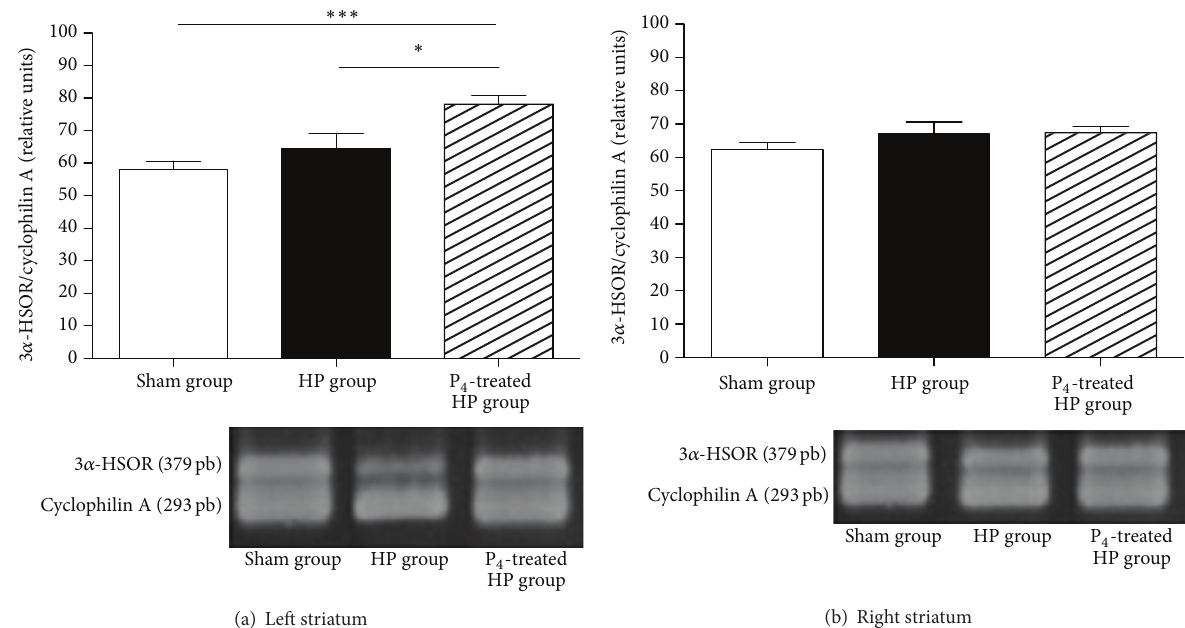
Figure 4: Gene expression of 3 𝛼 -HSOR in left (a) and right striatum (b). Results are expressed as mean ± SEM of relative units cDNA of sham, HP, and P 4 -treated HP groups; ∗ 𝑃 < 0.05 and ∗∗∗ 𝑃 < 0.001 (one-way ANOVA). Ethidium bromide fluorescence photograph of the gel electrophoresis of the amplification products, of sham, HP, and P 4 -treated HP. The gel photographs were quantified using ImageJ software (NationalInstitutesofHealth,USA)andexpressedasarbitraryunitsrelativetocyclophilinA.HPgroup(hemiparkinsoniangroup),P 4 -treated HP group (progesterone-treated hemiparkinsonian